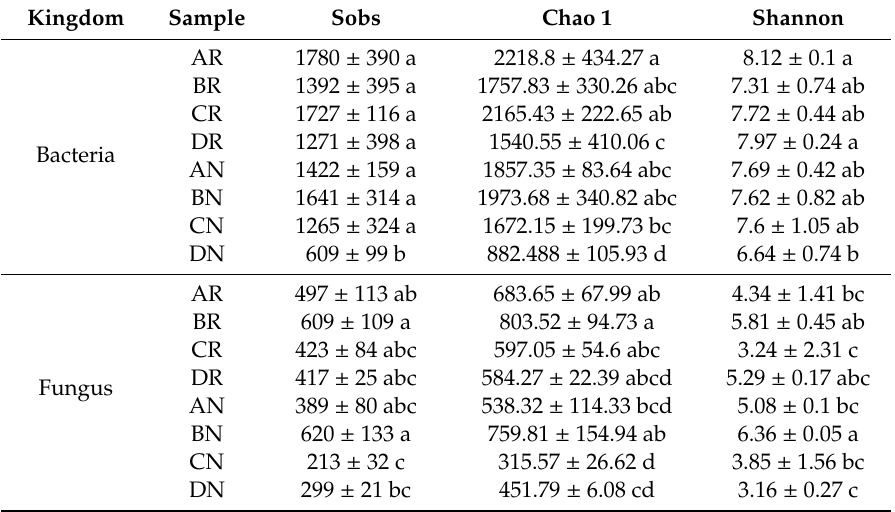
Table 1. Alpha diversity (Sobs, Shannon, and Chao 1 index) of bacteria and